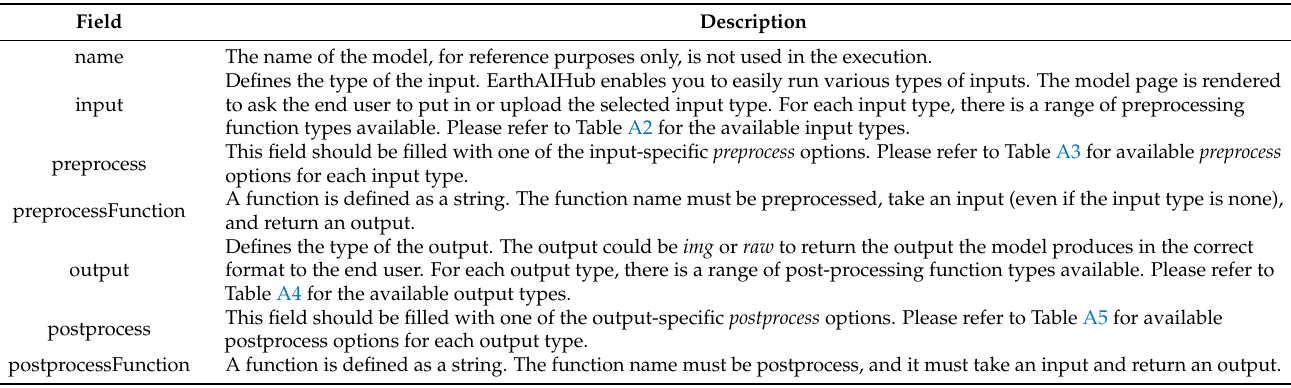
Table A1. Fields and their definitions for the config file.